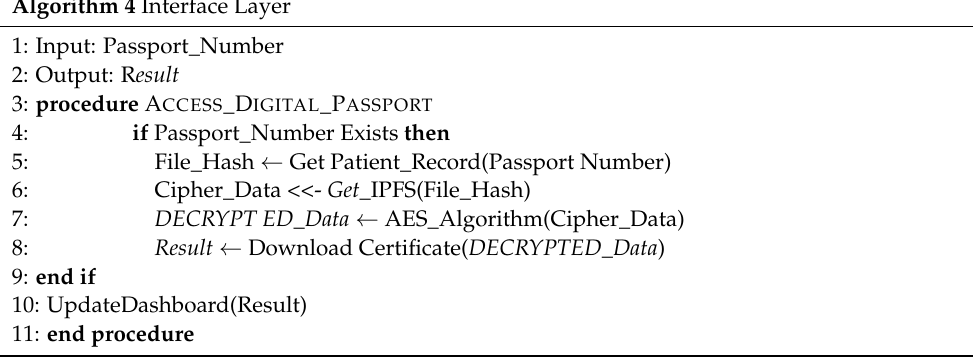
Algorithm 4 Interface